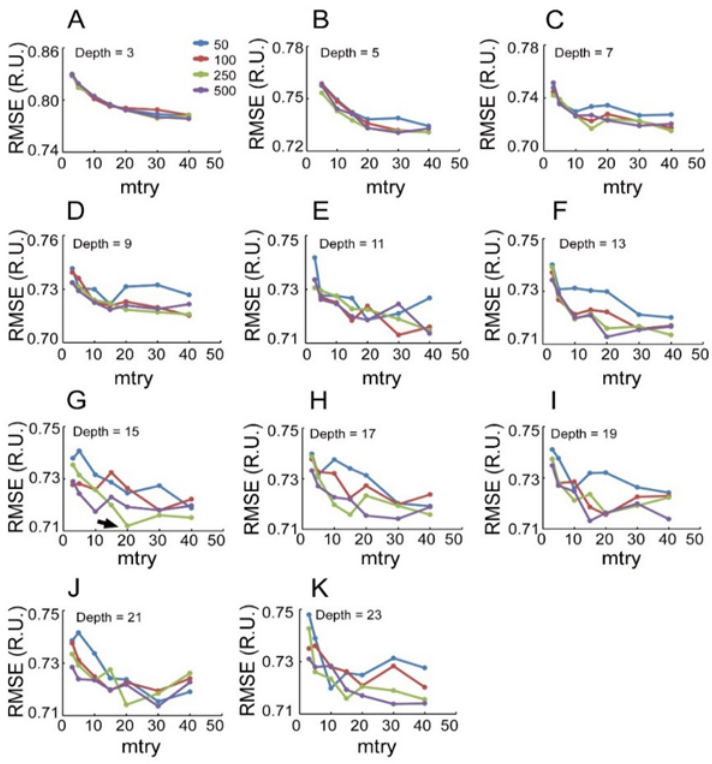
Figure 5. Presentation of all the random forest (RF) architectures root mean squared error (RMSE) grade in stomatal conductance experiment. Panels A-J represent a different depth (marked with a relative unit) of the regression tree, starting at 3 for Panel A and ending at 23 for Panel K. Parameter Mtry relates to the percent number of features to consider when looking for the best branch split; RMSE stands for the Root Mean Squared Rrror between the models’ selected samples average and the overall samples’ average. Curve colors represent the size of the RF where blue, red, green, and purple stand for 50, 100, 250, and 500 regression trees. Each point includes all the dataset (452 samples) repeated five times and averaged. Bold black arrow represents selected architecture for analysis.